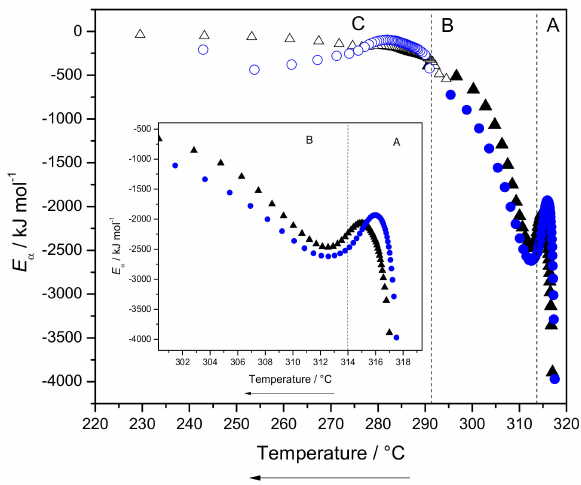
Figure 8. E α dependence vs. temperature computed from FSC and DSC data. Black triangles: PTFE; blue circles: PTFE / SiO 2 (c)F; open: Crystallization performed at the FSC cooling rates 500, 1000, 2000 and 5000 K · s − 1 ; solid: Crystallization performed at the DSC cooling rates 0.0167, 0.0333, 0.0833, and 0.3333 K · s − 1 . Inset: Magnification of E α vs. T curve in the temperature range of 300–320 ◦